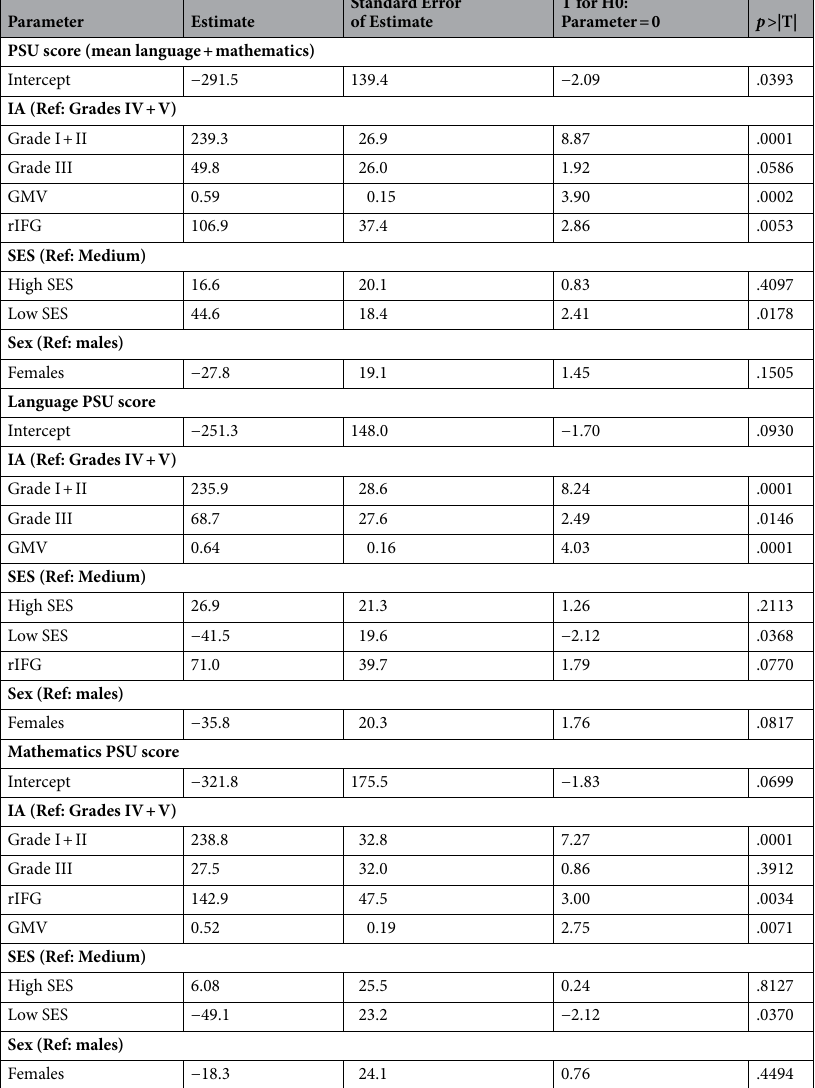
Table 6. Multiple regression analysis between the University Selection Test (PSU) (mean language + mathematics), language PSU and mathematics PSU scores (dependent variables) and the most relevant parameters (independent variables). Model R 2 = .811; Root MSE (Root mean squared error, standard deviation of the dependent variable PSU) = 71.4949; Model F Value = 55.76, p < .0001. Model R 2 = .770;